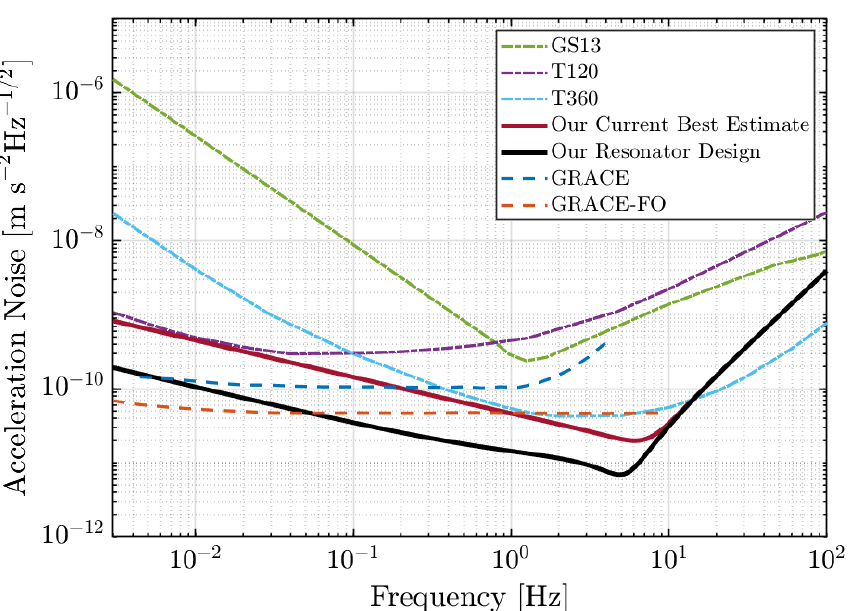
Figure 14. The projected noise floor of our optomechanical accelerometer compared to those of other technologies, including the GRACE [3] and GRACE-FO [4] accelerometers and the Geotech S-13, Trillium 120, and Trillium 360 seismometers [37]. Two traces are plotted for the noise floor of our accelerometer: our current best estimate using our experimental value of the Q -factor, and our resonator design using a value of Q calculated using models for the loss mechanisms of fused